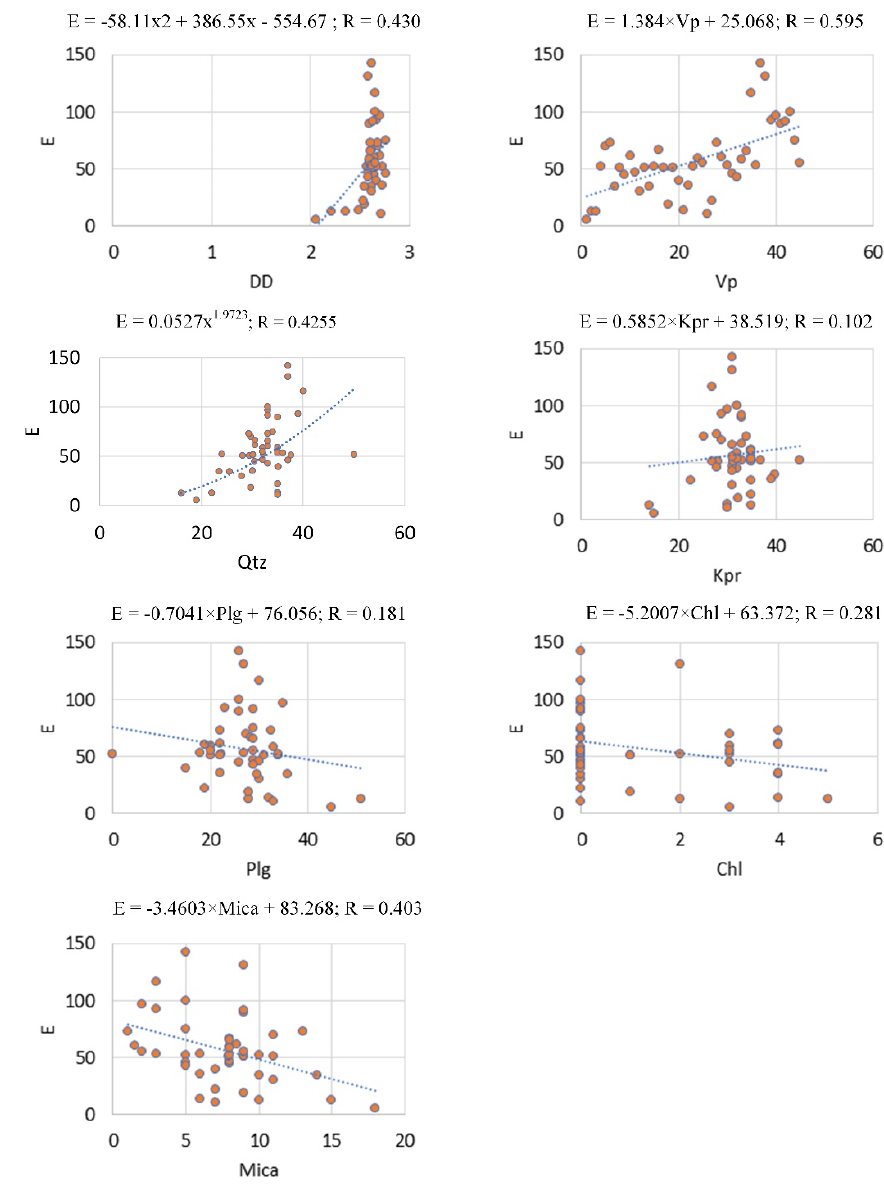
Figure 2. Simple regression models for predicting E. Table 2. Equations using various multiple regression techniques.